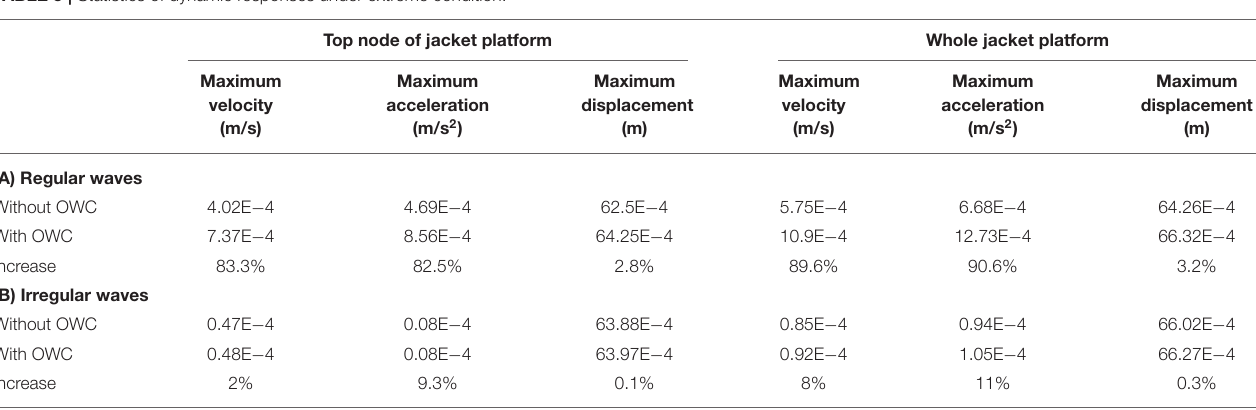
TABLE 5 | Statistics of dynamic responses under extreme condition. Top node of jacket platform Whole jacket